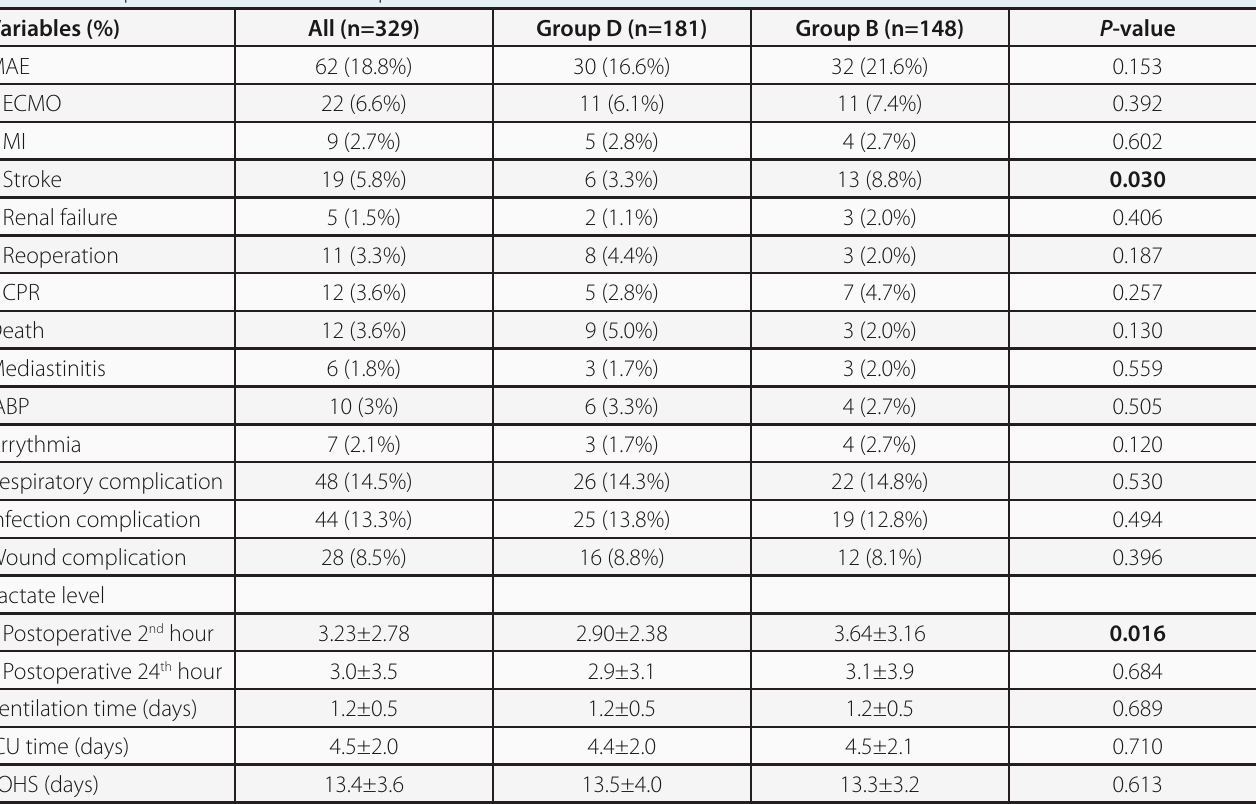
Table 3. Postoperative variables and